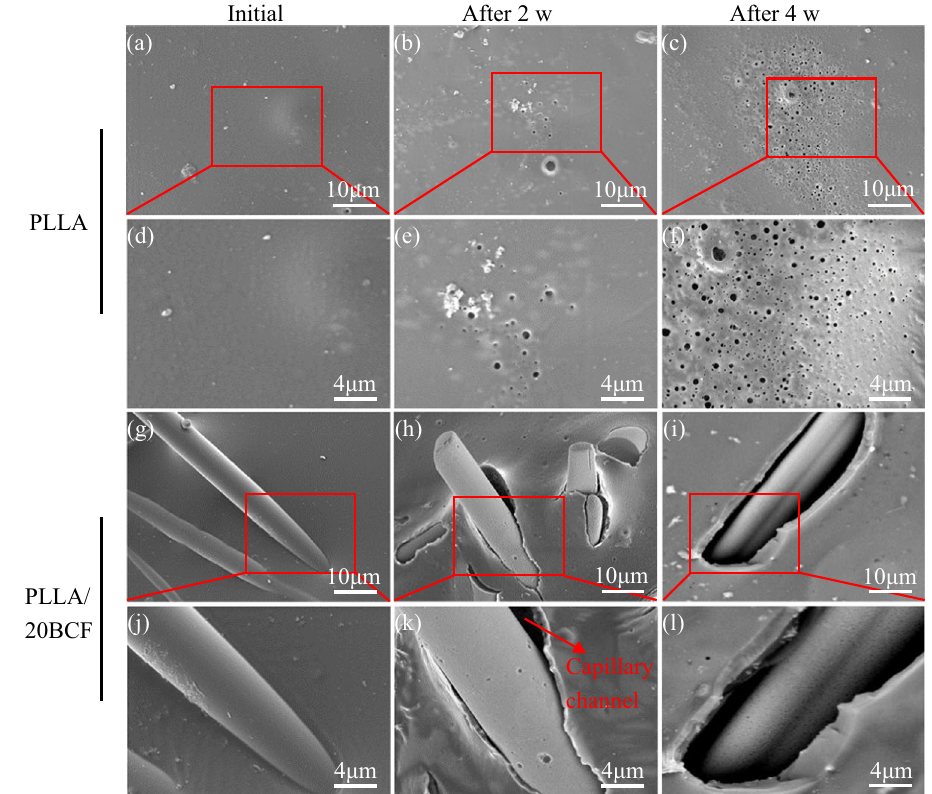
Fig. 3 Degradation morphologies of the scaffolds. Surface morphologies of ( a, d ) neat PLLA scaffold and the change in morphologies during degradation for ( b, e ) 2 weeks and ( c, f ) 4 weeks, surface morphologies of ( g, j ) PLLA/20BCF scaffold and the change in morphologies during degradation for ( h, k ) 2 weeks and ( i, l ) 4